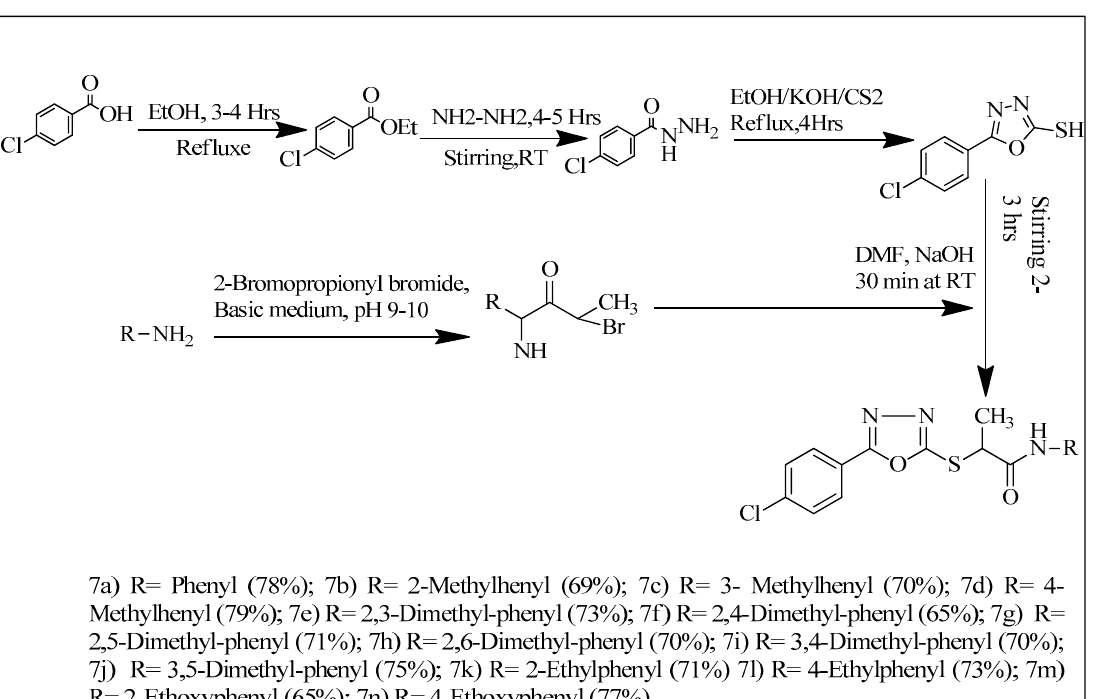
Figure 3. Schematic Diagram for the synthesis of 1, 3, 4 oxadiazoles [16].